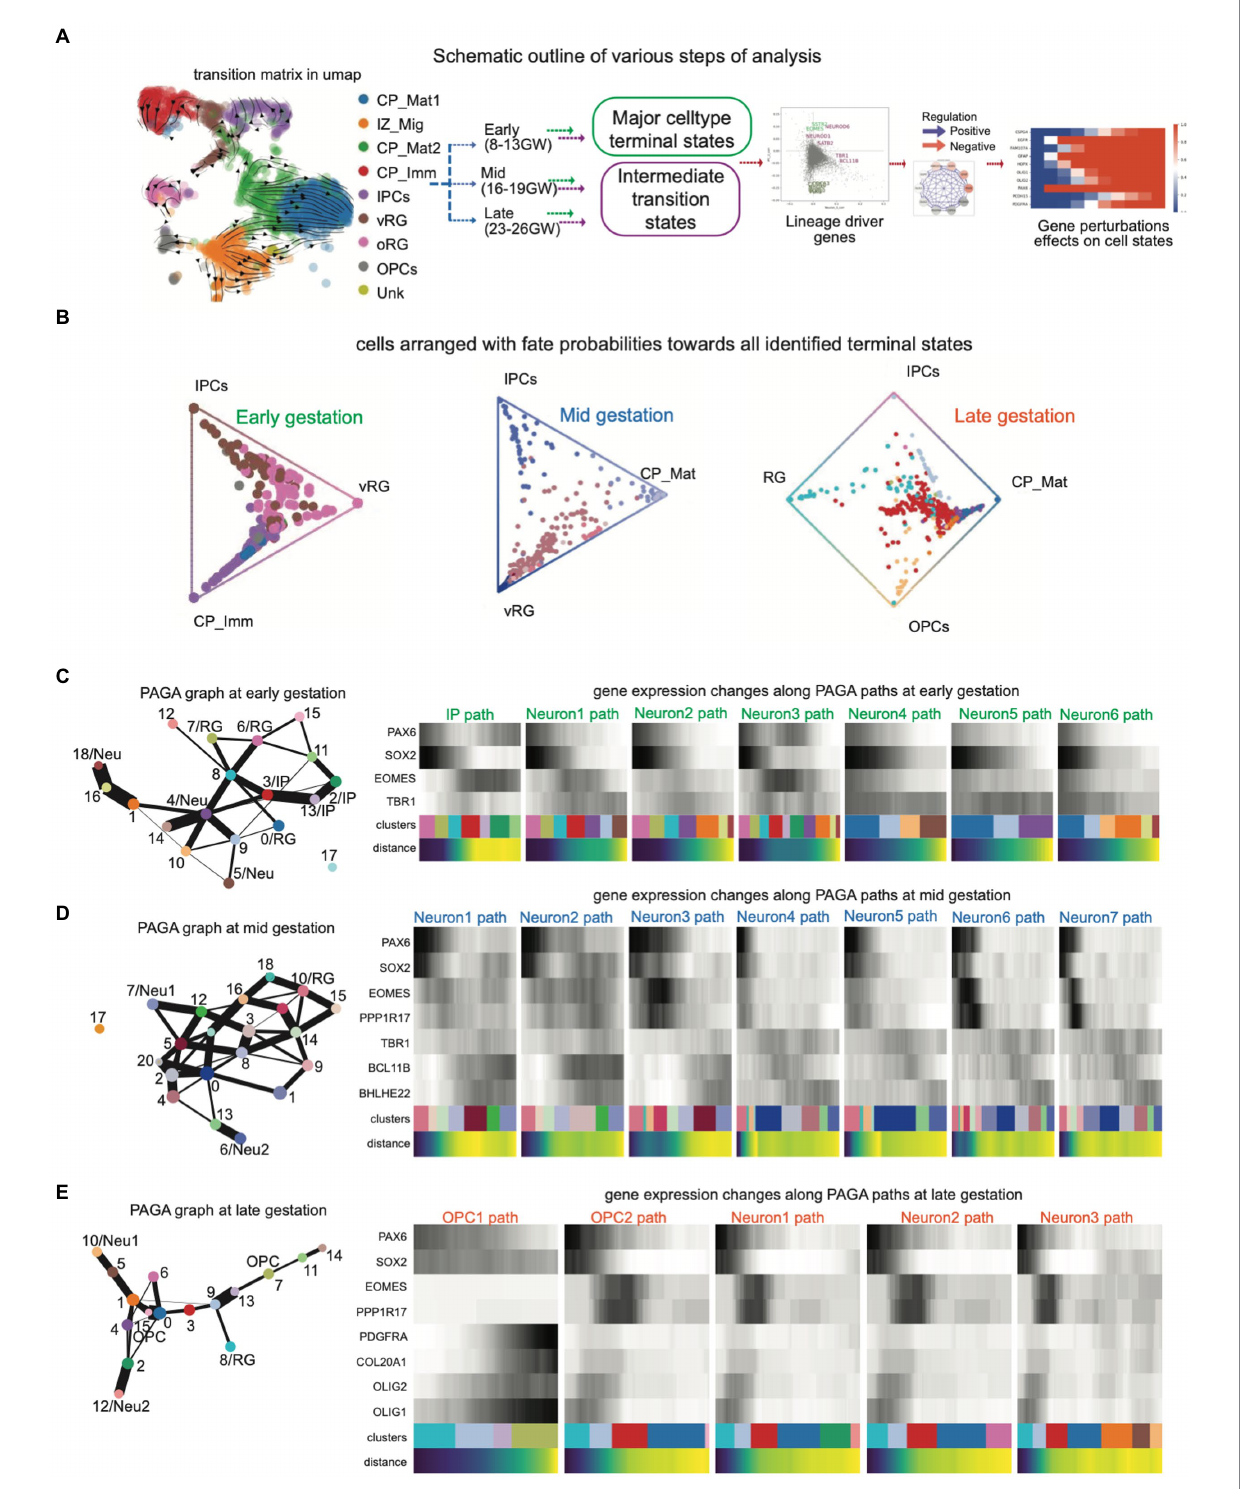
FIGURE 1 (A) Schematic outline of various steps of analysis: The scRNAseq dataset was processed for QC analysis and cluster identification with known cell type markers. Developmental stages were separated into early (8–13 GW), mid- (16–19 GW), and late (23–26 GW) stages and then terminal fates and their intermediate states were analyzed using CellRank and PAGA, resulting in lineage-specific novel genes. Gene regulatory network (GRN) and perturbation analysis were performed using the iQcell platform; (B) Summarized fate probabilities toward all terminal states. In this representation, uncommitted progenitors and immature cells can be seen near the center and committed cells are placed near one edge; (C–E) PAGA graphs show cell clusters in which only terminal major cell states are named while the rest of the cells are arranged in a graph connected with weighted edges for their nature. The PAGA graphs capture the proximity of progenitors and strong connections within neuronal clusters and then glial clusters; (C) PAGA graphs (left) and gene changes along PAGA paths (right) at early embryonic brain development; (D) PAGA graphs (left) and gene changes along PAGA paths (right) at mid-stage embryonic brain development; (E) PAGA graphs (left) and gene changes along PAGA paths (right) at late-stage embryonic brain